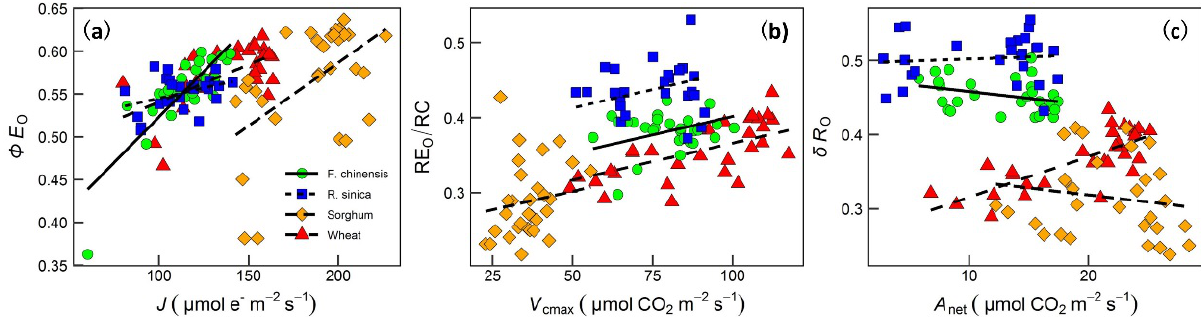
Figure 7. Linear regressions between photosynthetic traits reported in Zhu et al. [10,11] and chlorophyll fluorescence OJIP parameters. Panel ( a ) is for the modeled electron transport rate ( J ) vs. the quantum yield of electron transport ( Φ E o ) ( r 2 = 0.411, p < 0.0001; intercepts and slopes differed among species), Panel ( b ) is for the modeled maximum velocity of Rubisco carboxylation ( V cmax ) vs. electron flux leading to the reduction in the PSI end acceptor (RE o /RC) ( r 2 = 0.716, p < 0.0001; species shared similar slopes and different intercepts), Panel ( c ) is for net photosynthesis ( A net ) vs. the probability that an electron from the intersystem electron carriers is transported to the PSI end acceptor ( δ R o ) ( r 2 = 0.823, p < 0.0001; intercepts and slopes differed among species). Linear regression results are shown in Table S3. J and V cmax were modeled from net assimilation rate—intercellular CO 2 concentration ( A net — C i ) curves, and A net was measured under a light intensity of 1500 PPFD at 25 °C.